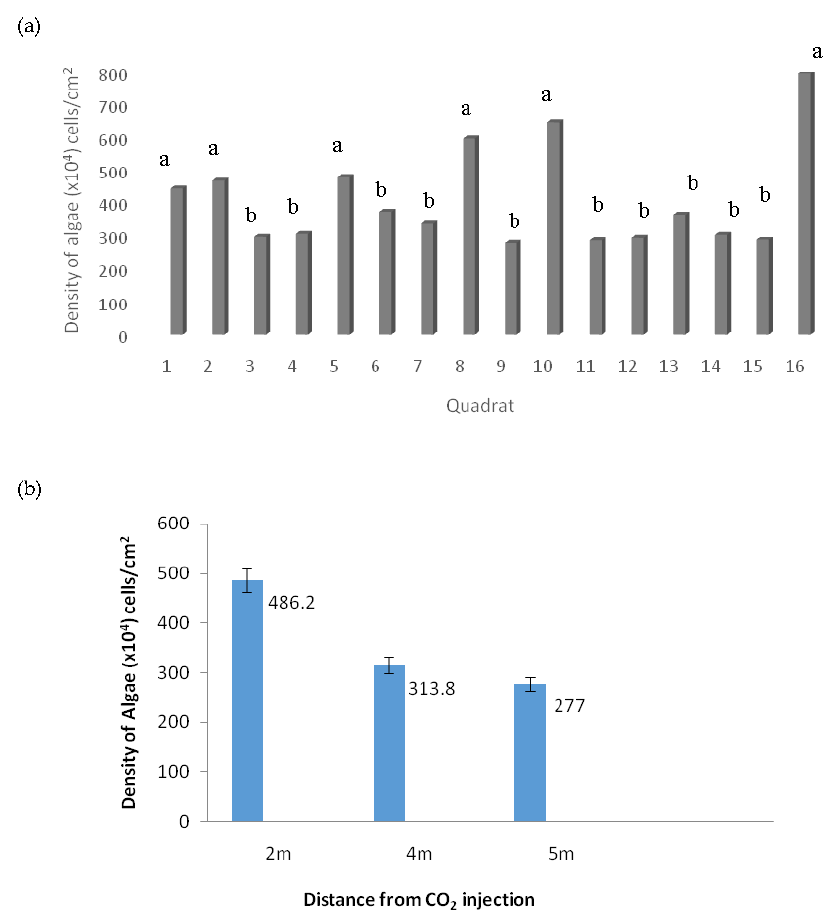
Figure 5. ( a ) Density of epiphytic terrestrial algae of 16 quadrats placed in the ring of the FACE system. ( b ) Mean algal density based on the distance and concentration from CO 2 injection to quadrats placement. 2 m, inner = 400 ppm; middle, 4 m = 440 ppm; 5 m, outer = 600 ppm. All error bars represent standard error of means (SEM).